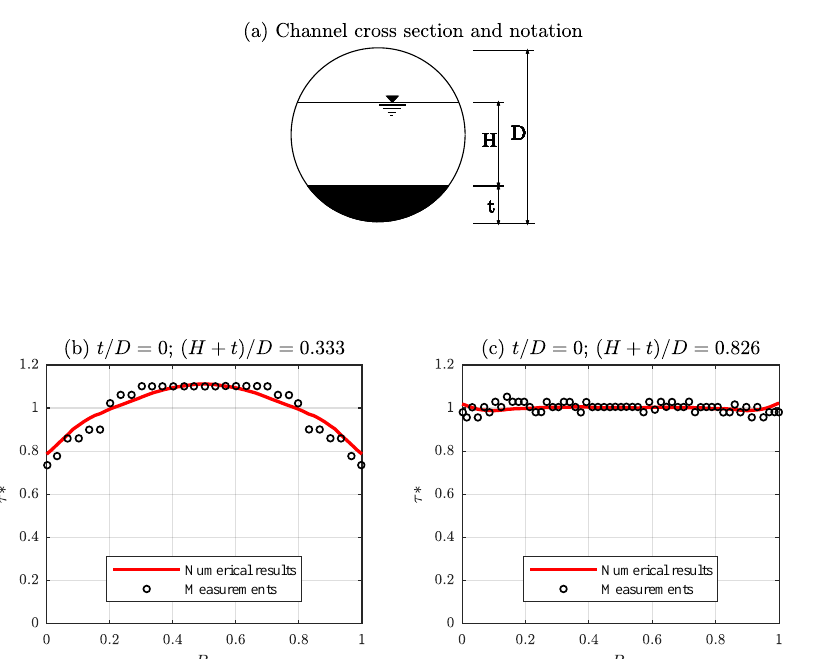
Figure 12. ( a ) Channel cross section and notation; and ( b , c ) comparison of calculated and measured boundary shear stress distributions in a smooth circular conduit of the experiments of Knight and Sterling